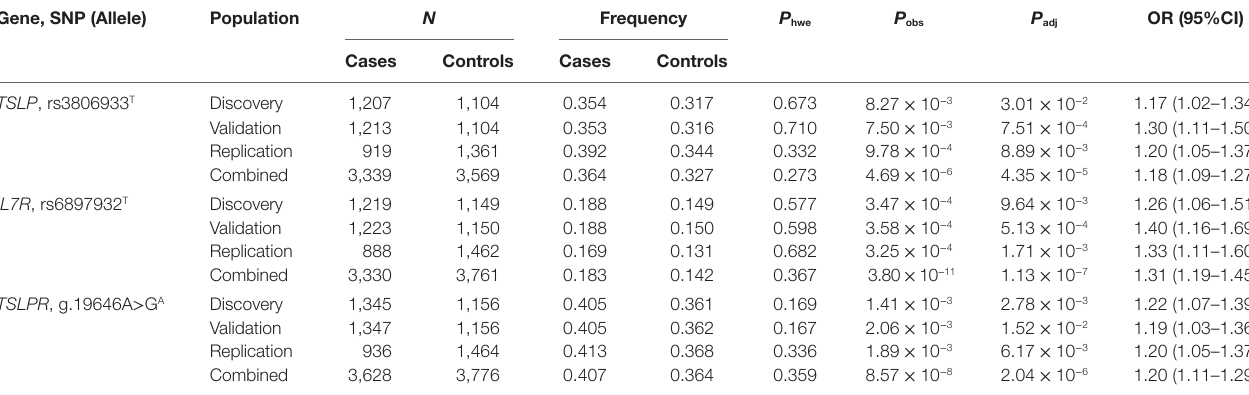
TaBle 2 | Allelic association analysis of rs3806933 in TSLP , rs6897932 in IL7R , and g.19646A > G in TSLPR with CAD in the studied Chinese Han population. gene, snP (allele) Population N Frequency P hwe P obs P adj Or (95%ci)